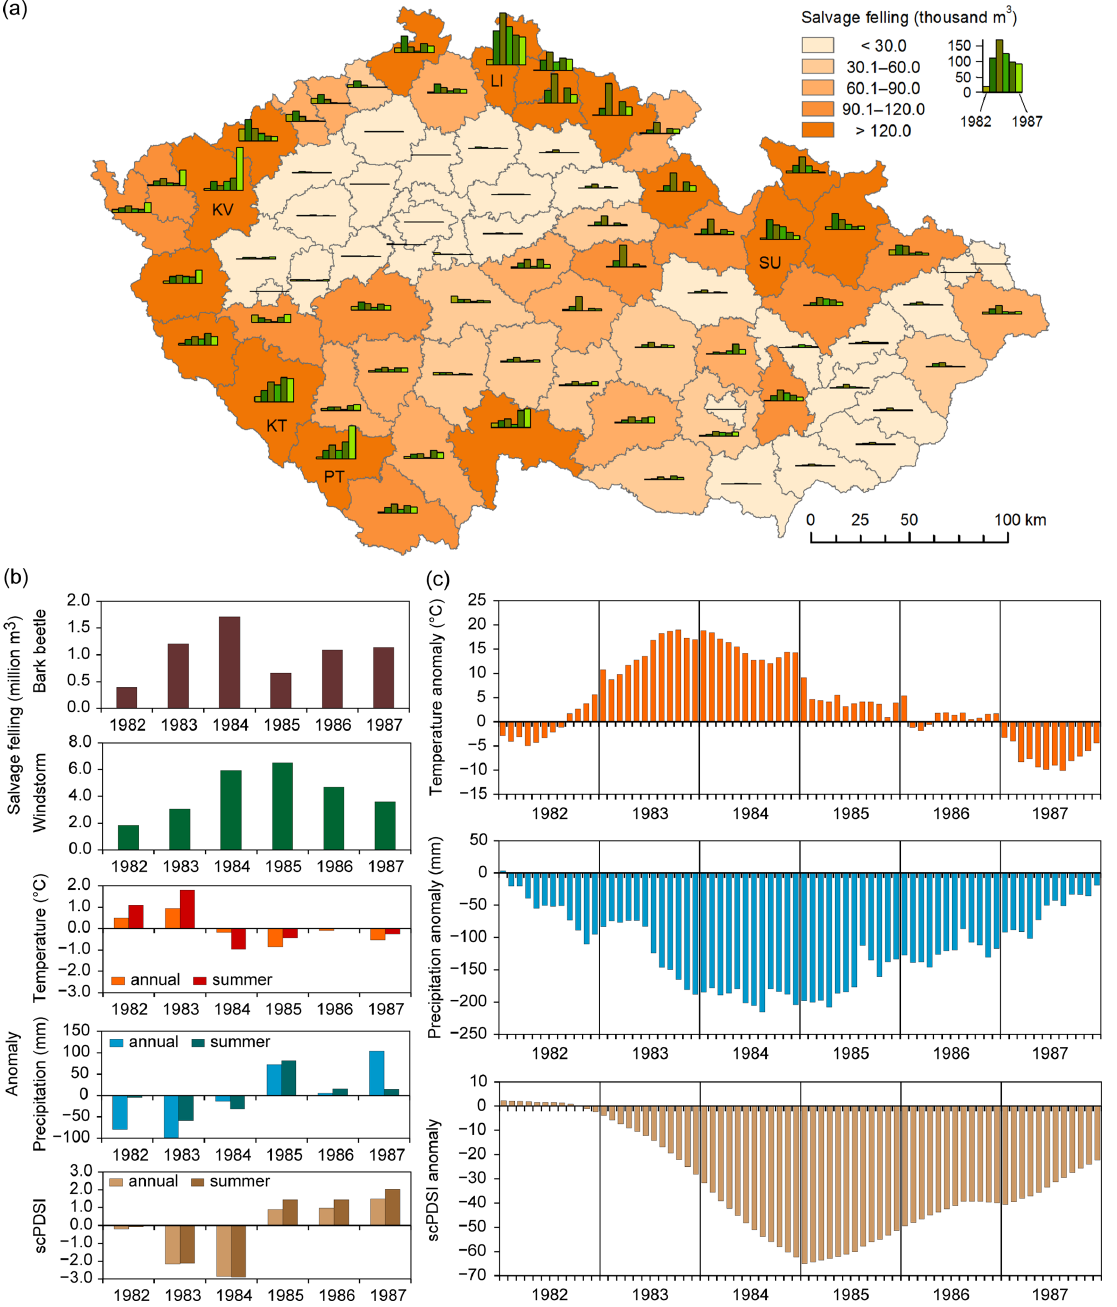
Figure 7. Bark beetle outbreak of the 1980s on the territory of the Czech Republic: (a) the volume of bark beetle salvage felling in 1982– 1987 in individual districts; (b) annual bark beetle and windstorm salvage felling, annual and summer anomalies of temperature, precipitation, scPDSI-12, and scPDSI-3 in 1982–1987; (c) cumulative monthly anomalies of temperature, precipitation, and scPDSI in 1982–1987 (1961– 1990 reference period). Abbreviations of districts: LI – Liberec; KT – Klatovy; KV – Karlovy Vary; PT – Prachatice; SU –